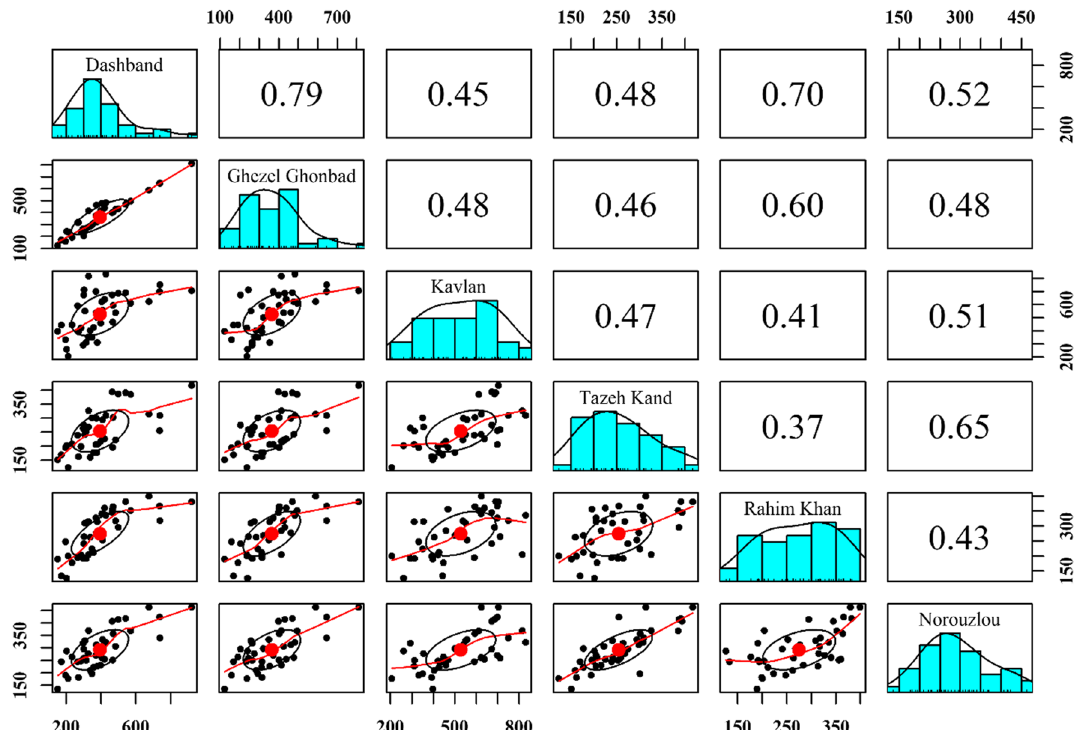
Fig. 3 The correlation between the annual rainfall records of the stations using Kendall’s Tau coefficient